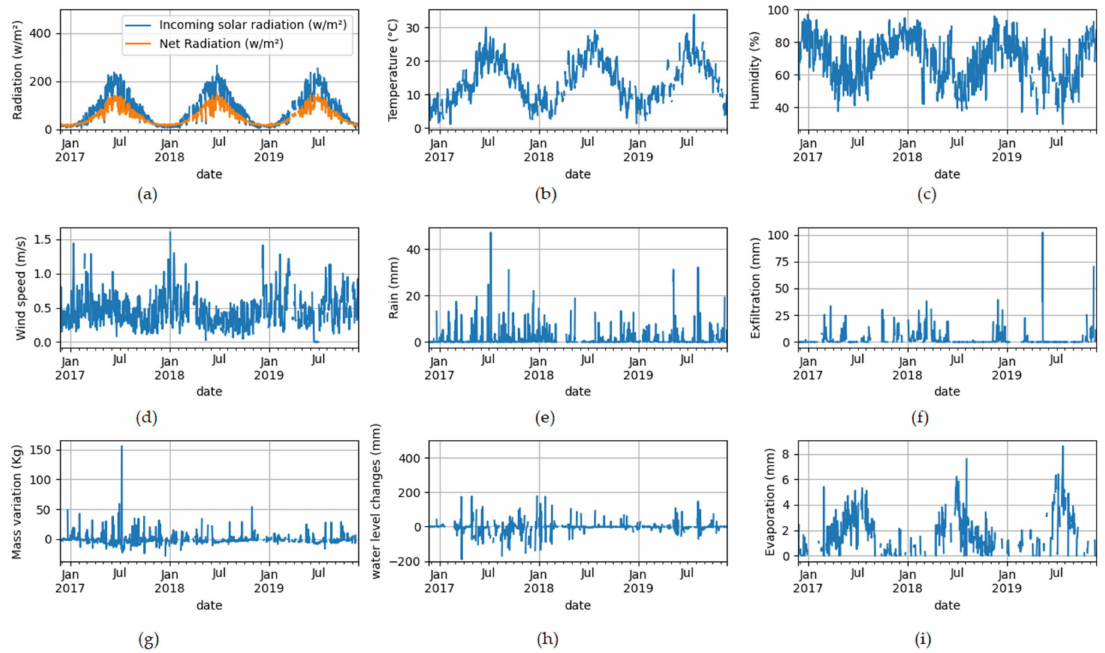
Figure 4. Meteorological variables: ( a ) daily incoming solar radiation and net radiation, ( b ) mean air temperature measured at 2 m, ( c ) relative air humidity, ( d ) wind speed, and ( e ) rainfall, ( f ) exfiltration, lysimeter daily ( g ) mass changes, ( h ) water level variation from the reference lysimeter 1 are added (mm), and ( i ) evaporation estimated from the evaporimeter.